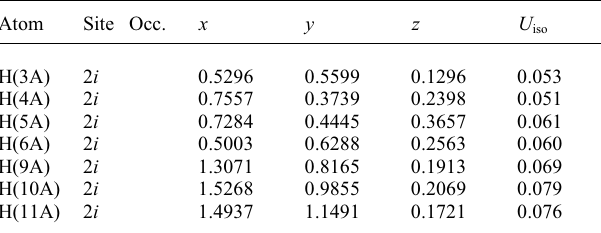
Table 2. Atomic coordinates and displacement parameters (in Å 2 )